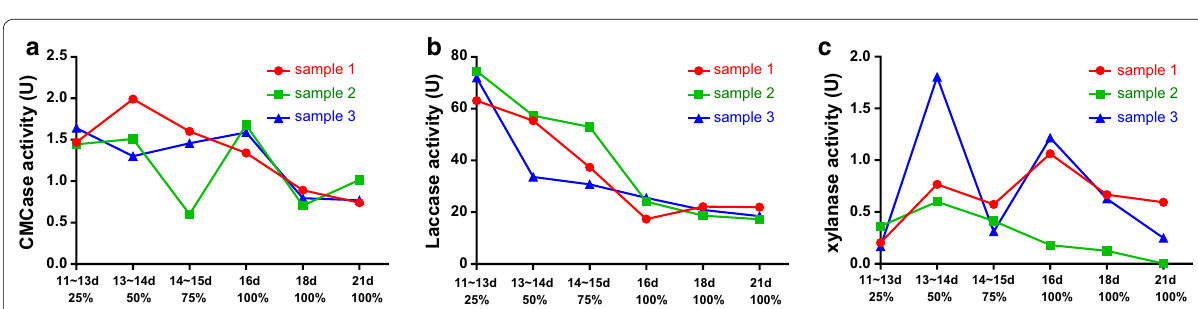
Fig. 4 a CMCase activity of A. brunnescens during solid-state fermentation. b Laccase activity of A. brunnescens during solid-state fermentation. c Xylanase activity of A. brunnescens during solid-state fermentation